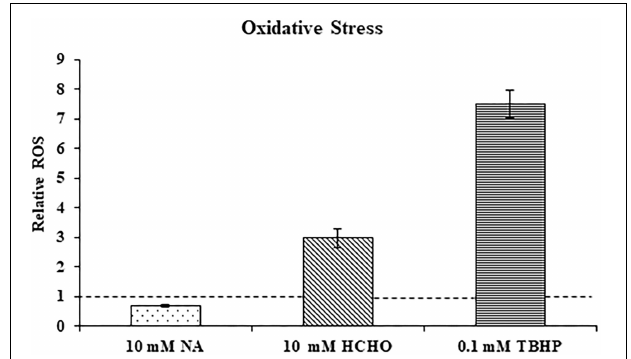
FIGURE 5 | NA does not induce oxidative stress. Relative levels of reactive oxygen species (ROS) in F. oxysporum conidia growing in PDB in response to 10 mM NA, 10 mM formaldehyde (HCHO), and 0.1 mM TBHP as measured by the DCFDA kit (see Section “Materials and Methods”). The dotted line represents the ROS status of untreated control. Values are mean ± SD and statistically significant with respect to control ( p < 0.05). Vertical lines represent standard error